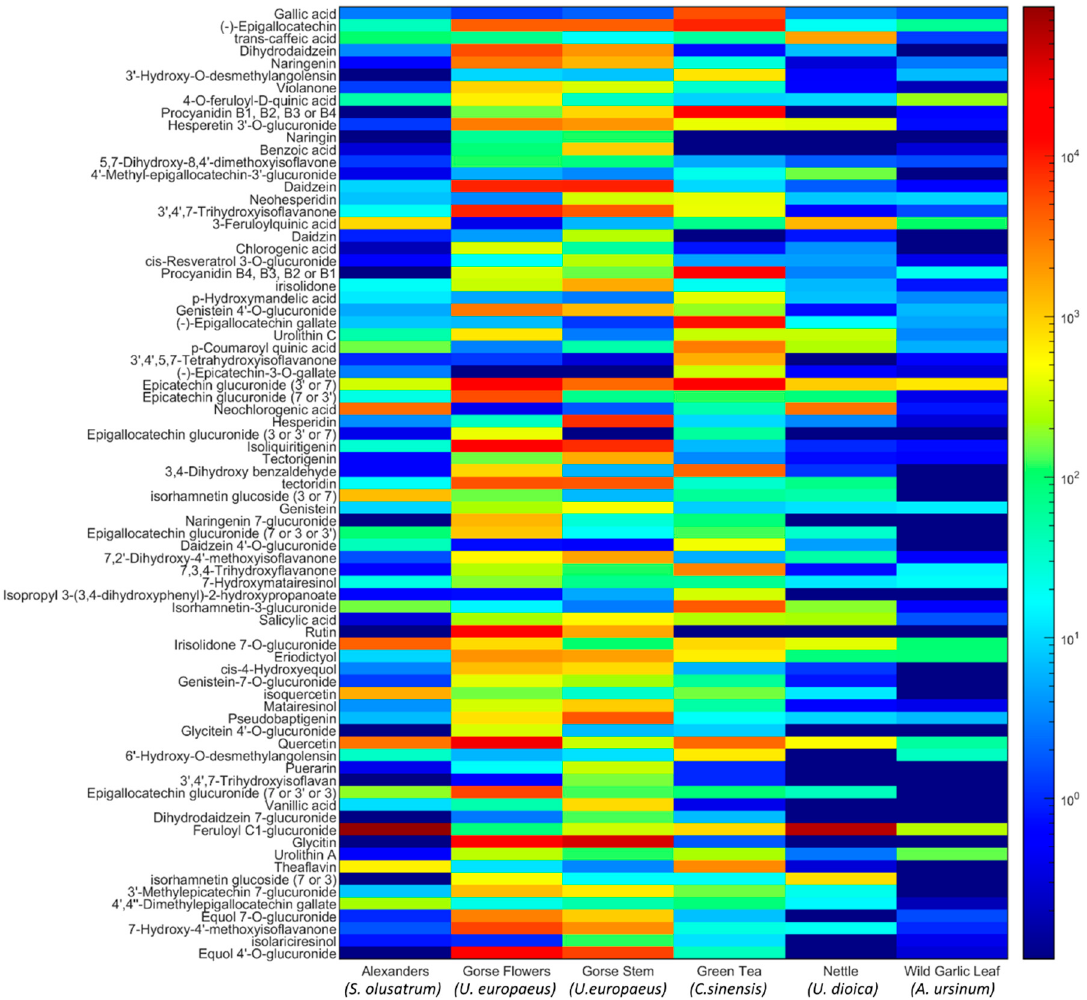
Figure 1. Heat map, using averaged abundances, created for each sample type across the 77 observed polyphenols. A loadings bi-plot was created as another overview of the data. Pareto scaling was used in this unsupervised principal component analysis (PCA). Sample replicates are tightly clustered and sample types show clear separation. The relationship between sample types and the data swarm of m / z values (x-variables) can also be seen (Figure